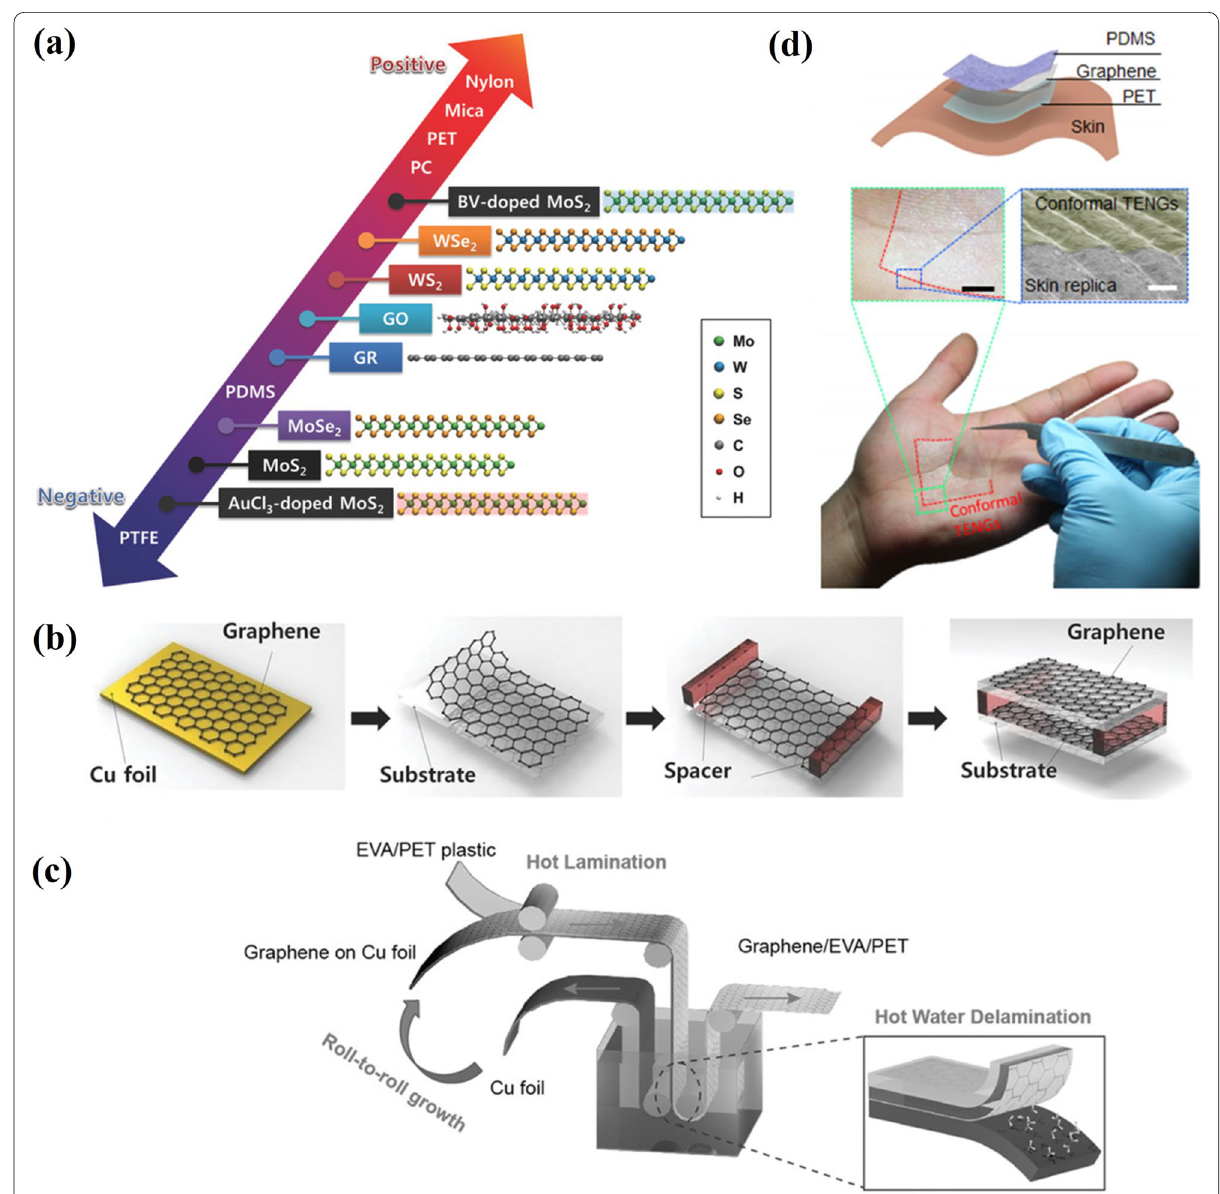
Fig. 6 Applications of 2D materials in TENG fabrication: a modified triboelectric series including 2D materials (Reproduced with permission from Ref. [48]); b a schematic of fabrication of 1L graphene-based TENG (Reproduced with permission from Ref. [52]); c a schematic of the roll-to-roll delamination of Cu and graphene onto EVA/PET substrate (Reproduced with permission from Ref. [53]); d a schematic of the conformal TENGs and images of the conformal TENGs attached on the palm (Reproduced with permission from Ref.